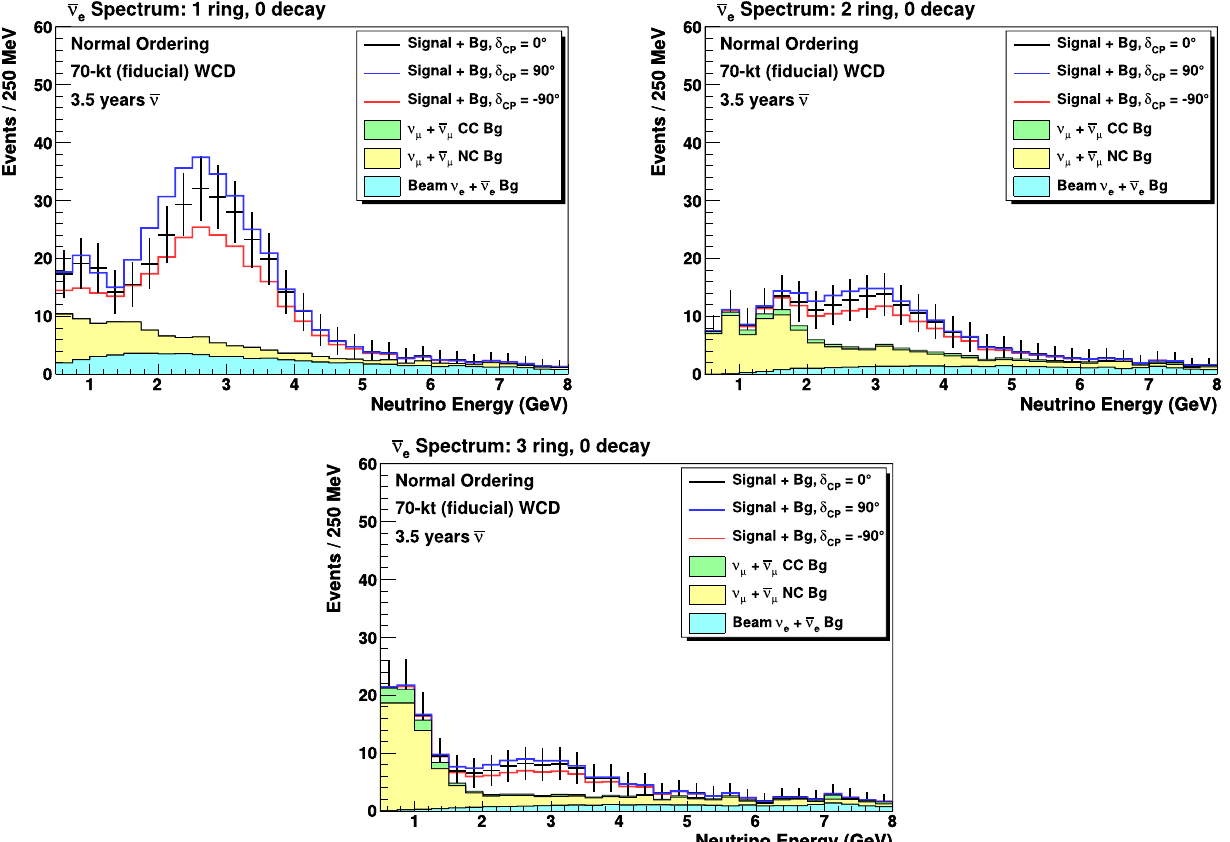
electrons. Note that the vertical scale is different compared to Fig. 5. SampleswithMichelelectronsarenotconsideredforantineutrinomode